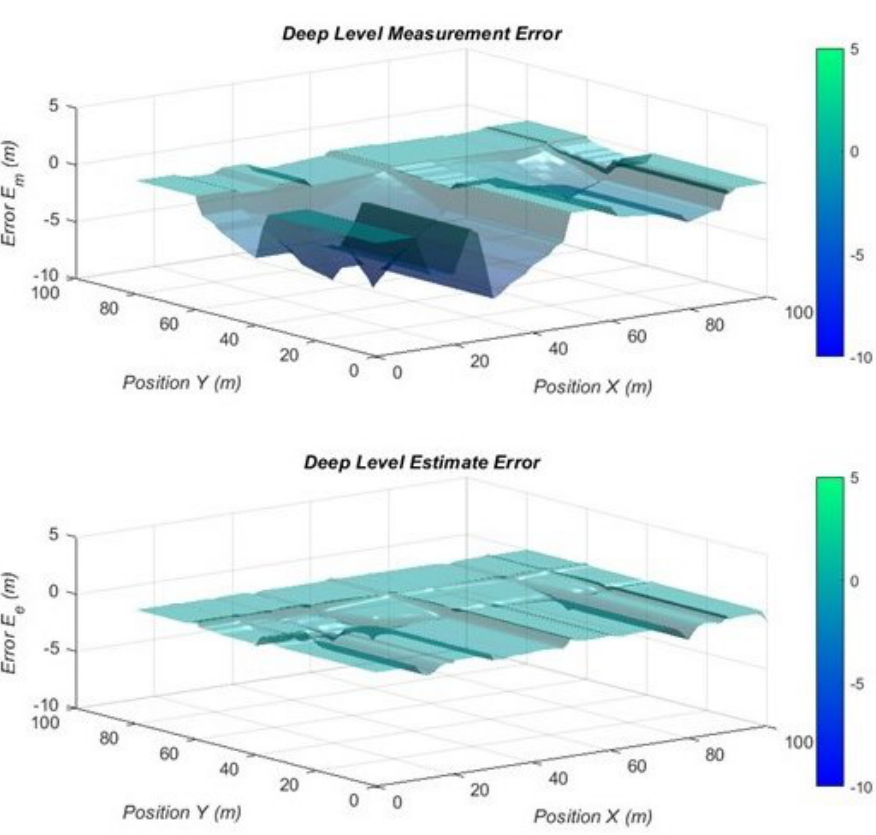
Figure 7. ( top ) Measured and ( bottom ) estimated error for a particular